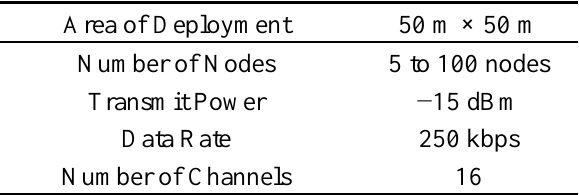
Table 3. Simulation